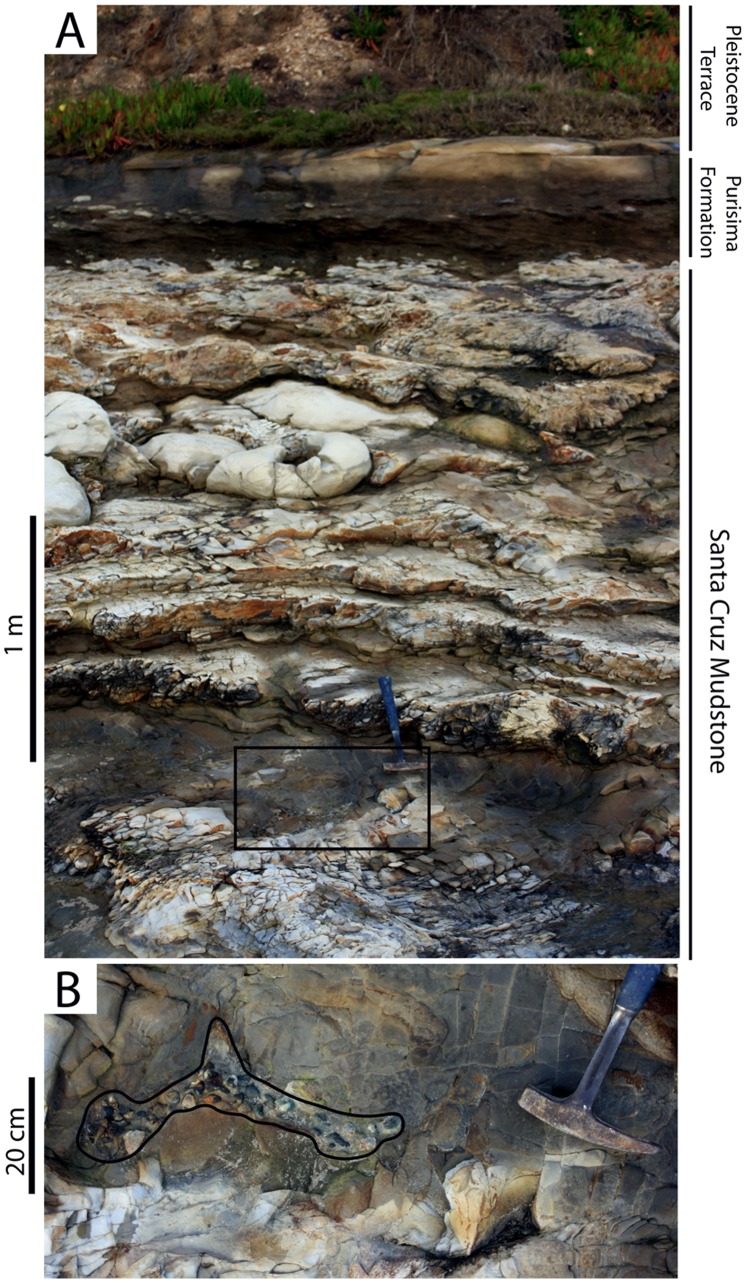
Bonebed debris deposited as fissure fill within burrows below the erosional base of the Purisima Formation (Bonebed 1) at the base of section 1.(A) Photograph of the Purisima Formation-Santa Cruz Mudstone contact; photograph taken on strike with strata at contact, and strata in lower 1/3 of photograph appear oblique due to outcrop shape and parallax. (B) Map-view photograph of pod of Purisima Formation bonebed debris and sandstone infilling Ophiomorpha burrows 2.5 meters below base of Purisima Formation.